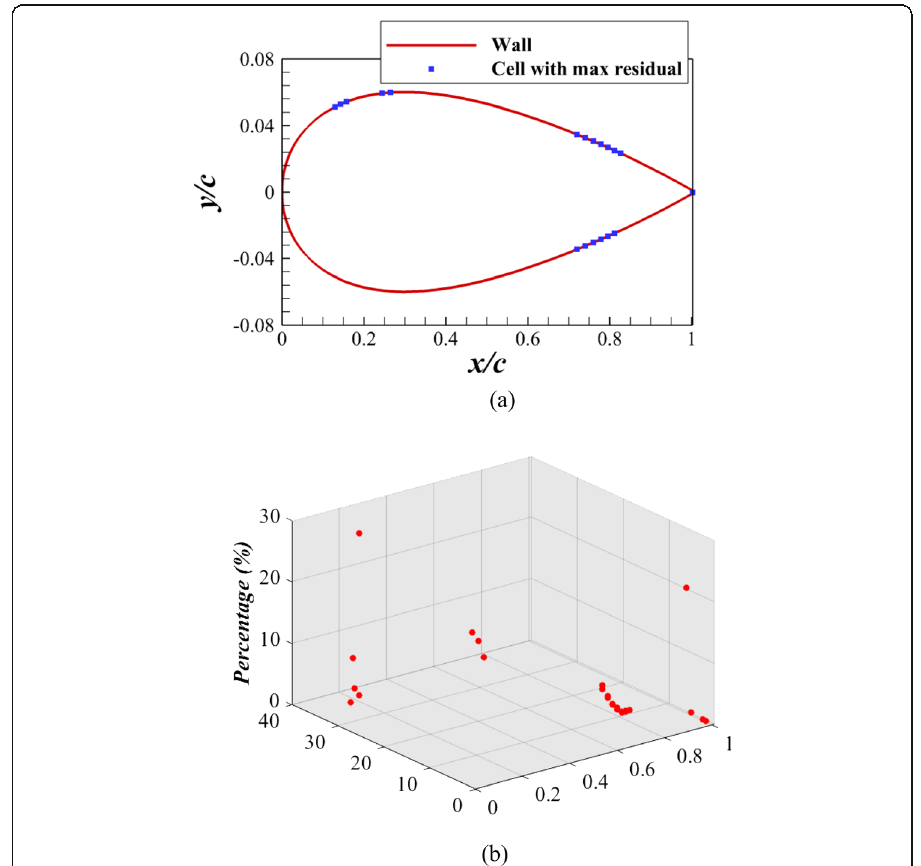
Fig. 19 The location and percentage of the cells with maximum residual after 6 × 10 4 pseudo steps